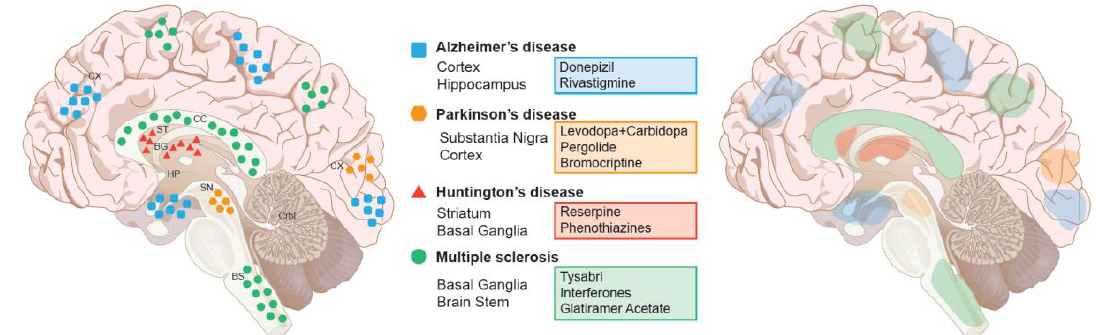
Figure 1. Major Neurodegenerative diseases, their associated regions, and current therapeutic interventions. Left panel: Brain disorders are color and shown in representative areas of the brain. Right panel: current pharmacological treatments and their areas of activity within the brain. Abbreviations: Basal ganglion (BG), Brain Stem (BS), Cerebellum (Crbl), Corpus callosum (CC), Cortex (Cx), Hippocampus (Hp), Striatum (St), Substantia Nigra (SN).